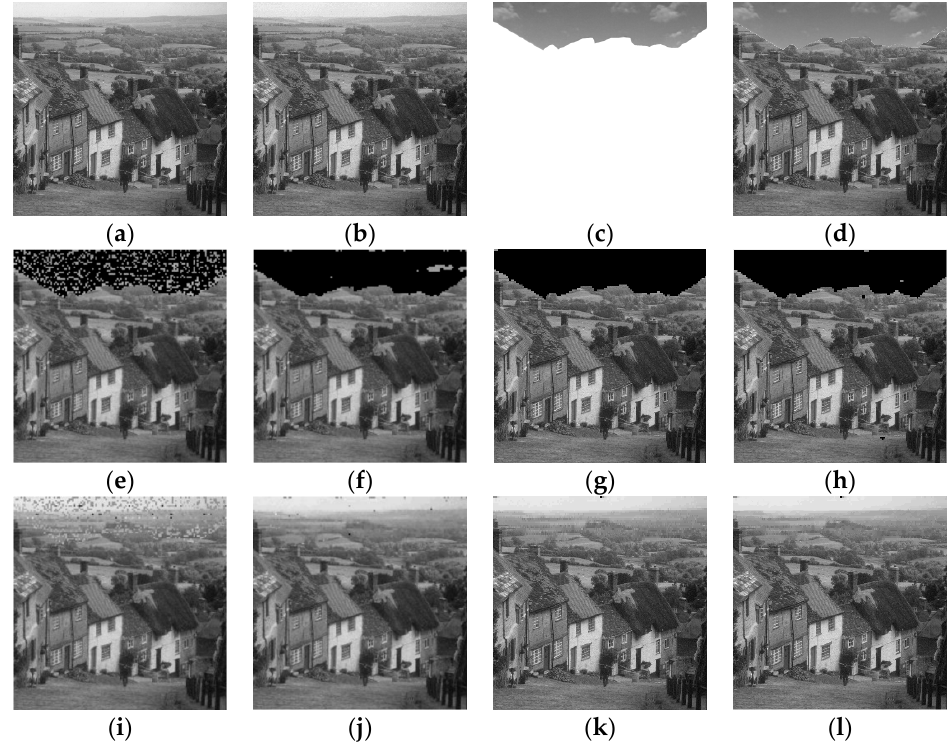
Figure 8. Tamper detection and recovery results of copy-move attack on Goldhill image: ( a ) original image; ( b ) watermarked image; ( c ) tamper reference; ( d ) tampered image; ( e ) tamper detection result of [8]; ( f ) tamper detection result of [9]; ( g ) tamper detection result of [7]; ( h ) tamper detection result of the proposed method; ( i ) recovery result of [8]; ( j ) recovery result of [9]; ( k ) recovery result of [7]; ( l ) recovery result of the proposed method. Table 3. Objective comparison of the recovery performance for a copy-move attack on the Goldhill image.